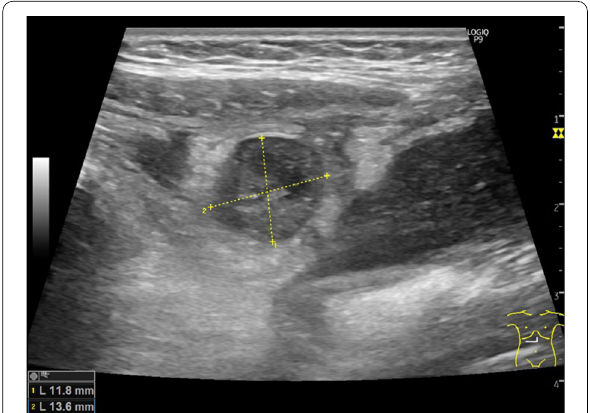
Fig. 1 Abdominal ultrasonography with color Doppler imaging. A nonvascular lesion of mixed echogenicity was recognized near the round ligament of the liver